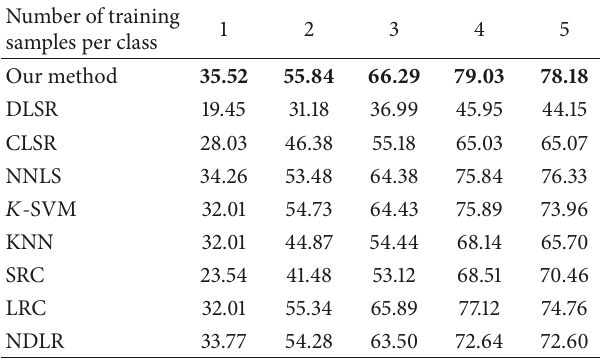
Table 1: Accuracies (%) of different methods on the GT database. Number of training